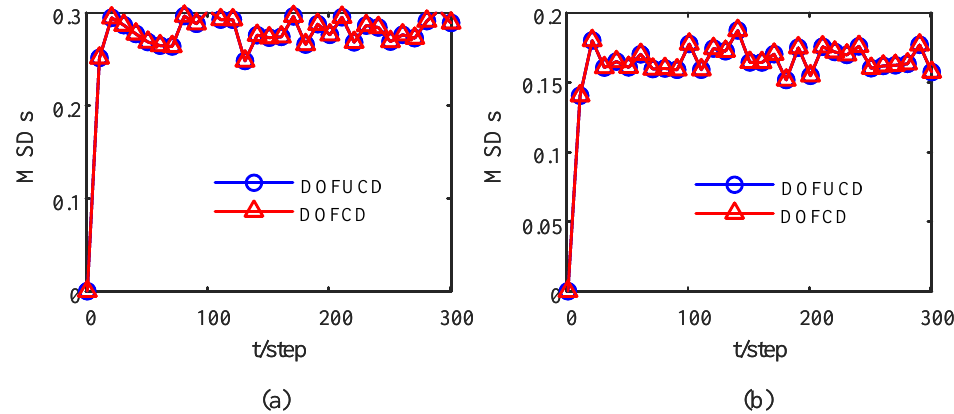
Figure 3. Comparison of MSDs of DOFCD and DOFUCD: ( a ) MSDs of the position filters; ( b ) MSDs of the velocity filters (authors’ own